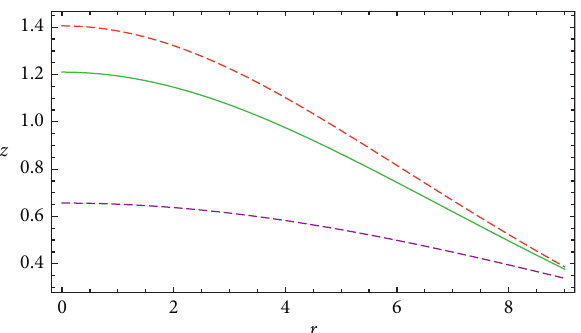
Figure 9: Graphical analysis of red-shift function z ( r ) for three small and large λ values using star Vela X-1 data.